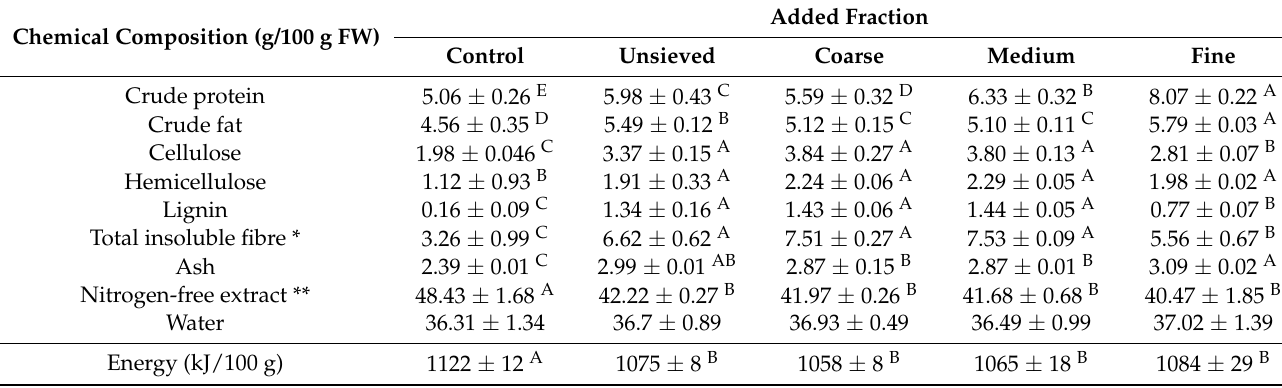
Table 2. Basic chemical composition of the control bread and the bread samples fortified with different flour fractions of milk thistle oilseed